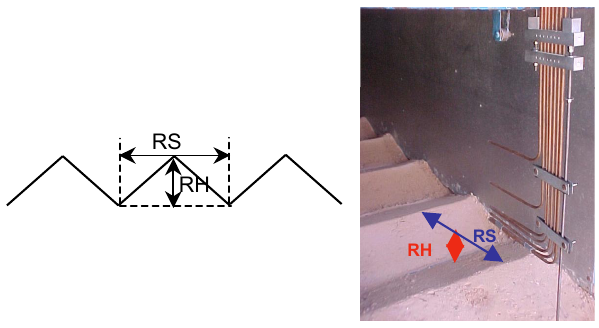
Fig. 1. Ridge geometric characteristics: Ridge spacing (RS) and ridge heights (RH)